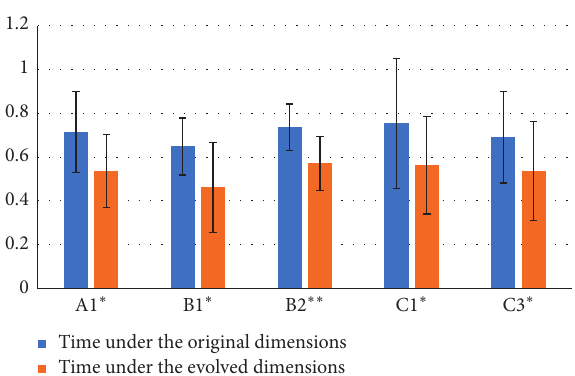
Figure 4: The completion time of the tasks with significant dif- ferences under the two HMIs with different